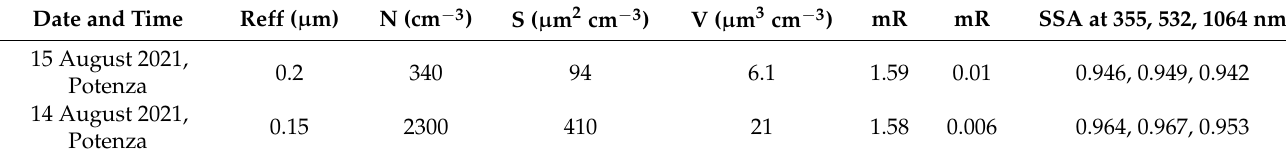
Table 2. Values from 22:37 to 23:19 and 00:46 to 02–16 of effective radius (Reff), number concentration (N), surface concentration (S), volume concentration (V), real part (mR), and imaginary part of the refractive index (mI), and single scattering albedo (SSA) at 355, 532, and